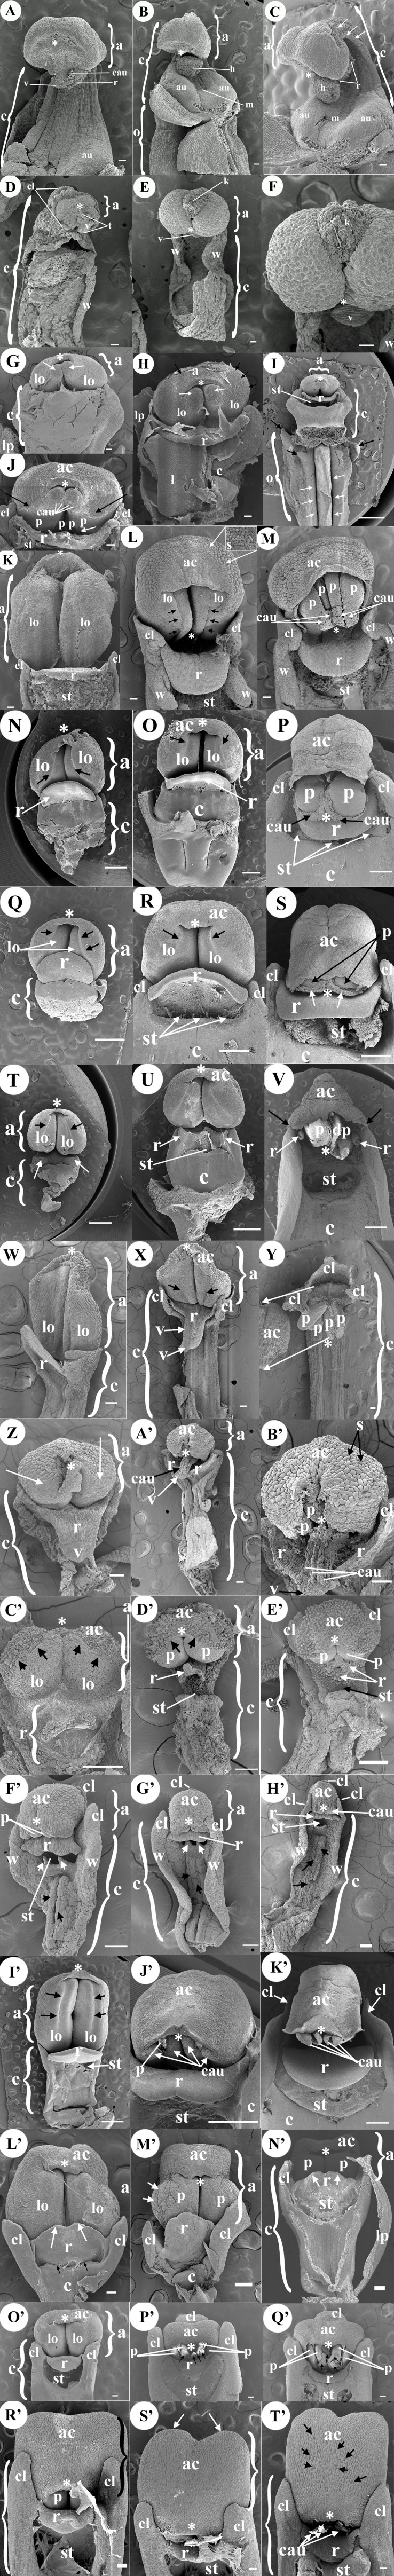
Development micrographs of anther.Late stages of development (column and anther) of Corallorhiza maculata (A, B, C). (A) Early incumbent anther. (B) Grown incumbent anther. (C) Lateral view bent over itself column and the incumbent anther. Govenia alba (D, E, F) (D) Early incumbent anther, column erect (same width throughout its length) and small developing wings. (E) Grown-up noticeably inflected anther. (F) Prominent keel in the middle of anther, just below the apical part of tegula (viscidium shield). Coelia triptera (G, H, I, J) (G) Early incumbent anther (H) Intermediate late stage incumbent anther. (I) Anther totally inflected, column hexagon-shaped, base joins the ovary which has pointed projections (black arrows) and with large grooves that cross longitudinally (white arrows). (J) Close-up of anther at anthesis, black arrows point the limit between anther cap and each pollinium respectively (two pairs of granulose caudicles exposed at apex). Bletia purpurea (K, L, M); (K) Early erect anther, slightly sub quadrate, bilobate with a trapezoid apex. (L) Intermediate late stage, anther inflected, the cucullate anther cap with actinocytic stomata embedded in its upper part (white arrows, close-up in the inset and Fig. 4B). (M) Anthesis, anther inflected, anther cap fully developed, pollinia (four upper visible), caudicles in the apex, at sides column wings. Chysis bractescens (N, O, P) (N) Early anther, erect, round shaped, bilobate with longitudinal lines marked on its epidermal tissue (black arrows). (O) Intermediate late stage anther, more quadrate and slightly less erect (apex with some degree of inflection), anther cap visible. (P) Galeate anther totally inflected, cucullate anther cap. A pair of pollinia exposed, with two laminar caudicles (one pair, black arrows) which surround the pollinia. Chysis limminghei (Q, R, S); (Q) Early anther, erect, round, bilobate with longitudinal lines marked on its epidermal tissue (black arrows). (R) Intermediate late stage anther, more quadrate, slightly less erect (apex with some degree of inflection), cucullate anther cap visible. (S) Galeate anther, totally inflected, cucullate anther cap. A pair of pollinia exposed with two laminar caudicles (one pair, white arrows). Chysis laevis (T, U, V); (T) Early erect anther, apex pronounced (trapezoid shaped), half round shaped, bilobate with longitudinal lines marked on its epidermal tissue (black arrows). Two very inconspicuous rostellum primordia (white arrows). (U) Intermediate late stage anther, slightly less erect (apex with some degree of inflection), bilobate, anther cap visible. Rostellum appendages vestiges underdeveloped (white arrows). (V) Incumbent anther, the anther cap conical shaped (like a hood), coalescent (fused by the sides to the column), dehiscent pollinia, open, without caudicles. No rostellum developed, only two appendixes underdeveloped and rolled on themselves (white arrows). Isochilus major (W, X, Y); (W) Early erect anther, semi-rectangular vertical with a pointed apex, biloculate. Column narrow and slender. (X) Intermediate late stage anther, semi rectangular shaped, pointed apex of conspicuous thickened cells, biloculate, each locule with longitudinal division (black arrow). (Y) Four elliptical inflected pollinia. Anther cap was not observed in this stage because it was lost during dissection; the lone structure (anther cap) was placed and observed at the side of the column in the slide (white arrows). Ponera juncifolia (Z, A′, B′); (Z) Early erect anther, rounded and bilobed, each lobule ovoid (white arrows). (A′) Intermediate late stage anther with caudicles exposed. (B′) Anther cap very conspicuous with actinocytic stomata embedded (black arrows). Two pollinia visible in each locule, four long caudicles exposed. Stelis ciliaris (C′, D′, E′) (C′) Early anther erect bilobed, each lobule ovoid with a small rounded apex, anther cap beginning its differentiation from the tissue of the rest of the anther, a clearly marked line delimits it (black arrows). (D′) Intermediate late stage anther, bilobed, anther cap clearly marked (black arrows) below two ovoid pollinia in close contact to upper part of rostellum tip (bifid viscidium, white arrow). (E′) Incumbent anther, anther cap with inverted heart shape, two pollinia exposed, in close contact to the tip of rostellum the bifid viscidium with abundant secretions. Specklinia digitale (F′, G′, H′) (F′) Inflected anther, cucullate, tip of two pollinia exposed. Column beneath with two teeth (white arrows). Below column narrows and canaliculated (black arrows). Column wings differentiated. (G′) Anther slightly more inflected, column with two teeth (white arrows). (H′) Inflected cucullate anther, two caudicles exposed, column is slim and long, canaliculated in the middle portion (black arrows), and with vertical wings. Laelia speciosa (I′, J′, K′) (I′) Erect anther, quadrate, bilobed, with a trapezoidal apex. Lobules with median longitudinal division each (black arrows). Column short and narrow. (J′) Intermediate late stage inflected anther, anther cap sub-globose with round striated cells. Underneath four caudicles visible. (K′) Inflected anther, the anther cap is oblong, with its apex folded up. Four large granulose caudicles are exposed in two pairs. Oestlundia ligulata (L′, M′, N′) (L′) Early erect anther, ovoid, bilobed, upper part by the apex a pleat of tissue is formed, early differentiation of the mid-part of the anther cap. (M′) Intermediate late stage inflected anther, bilobed with anther cucullate. (N′) Inflected anther, sub-cubic almost straight, two pollinia visible. Prosthechea squalida (O′, P′, Q′); (O′) Early erect anther, oblong and bilobed. (P′) Intermediate late stage inflected anther inflected the anther cap ellipsoid. Under anther cap four pollinia, two pairs of caudicles exposed (white arrows). (Q′) Inflected anther, anther cap truncate obovate shaped. Under it four pollinia, with four large, granulose caudicles in two pairs. Encyclia microbulbon (R′, S′, T′). (R′) Inflected anther quadrate with upper corners rounded, under anther cap two pollinia can be seen, (S′) More inflected anther, sub-quadrate with upper part bi-lobed and corners rounded (white arrows). At the apex of anther cap tip of two pollinia exposed. (T′) Inflected anther, obcordate semi-quadrate. Anther cap with abundant semi-actinocytic stomata (black arrows). Below anther cap, four pollinia are visible and two pairs of caudicles exposed. Scale Bars: A, B, C, D, E, F, G, H, J, K, L, M, W, X, Y, Z, A′, B′, C′, D′, E′, F′, G′, H′, L′, M′, N′, O′, P′, Q′, R′, S′ = 100 µm. I, N, O, P, Q, R, S, T, U, V, I′, J′, K′ = 1 mm. Abbreviations: *, anther apex; a, anther; ac, anther cap; ap, appendage; au, auricle; c, column; cau, caudicle; cl, clinandrium; dp, dehiscent pollinia; h, hamulus; l, lip; lo, lobule; lp, lateral petal; m, mentum; o, ovary; p, pollinium; r, rostellum; s, stomata; st, stigma; t, tegula; v, viscidium; w, column wings. Photo Credit SEM Images: Silvia Espinosa Matías. Figure edition: Benjamín Valencia-Nieto.